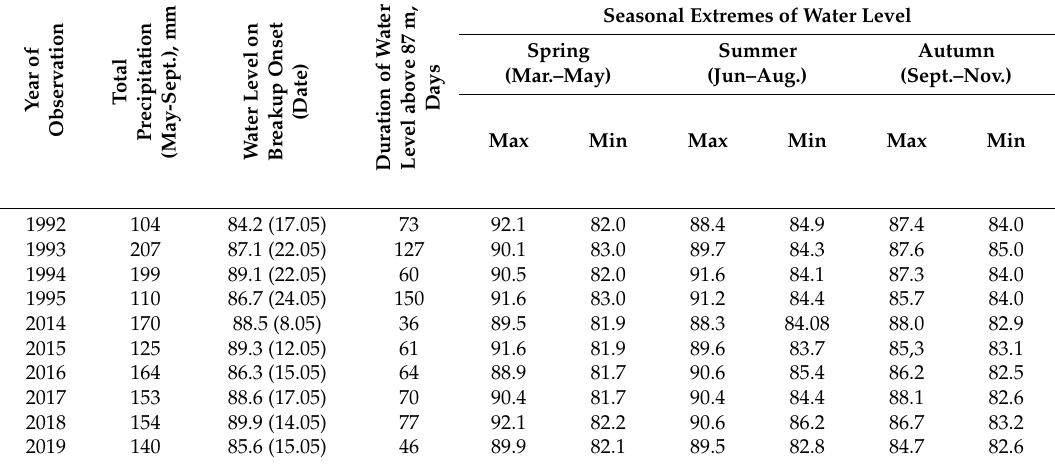
Table 1. Lena River water levels and summer precipitation in the Yakutsk area for 1992–1995 and